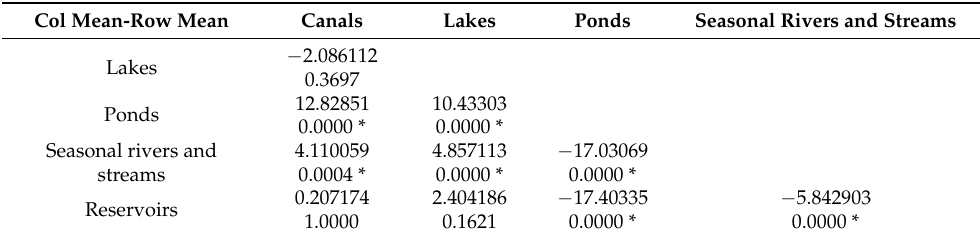
Table A4. 2005 Dunn’s post hoc tests, with p -values adjusted with the Bonferroni method. Col Mean-Row Mean